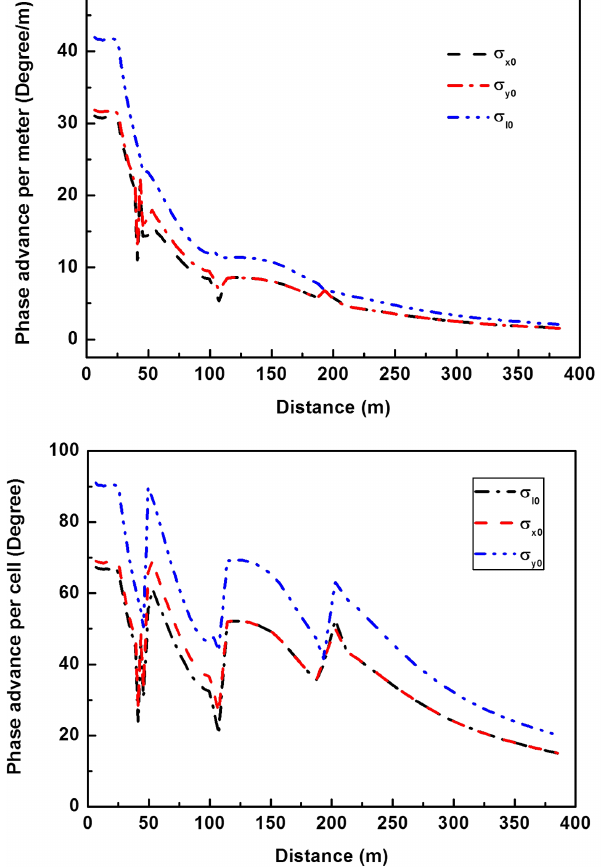
FIG. 21. Evolution of the emittance along the main